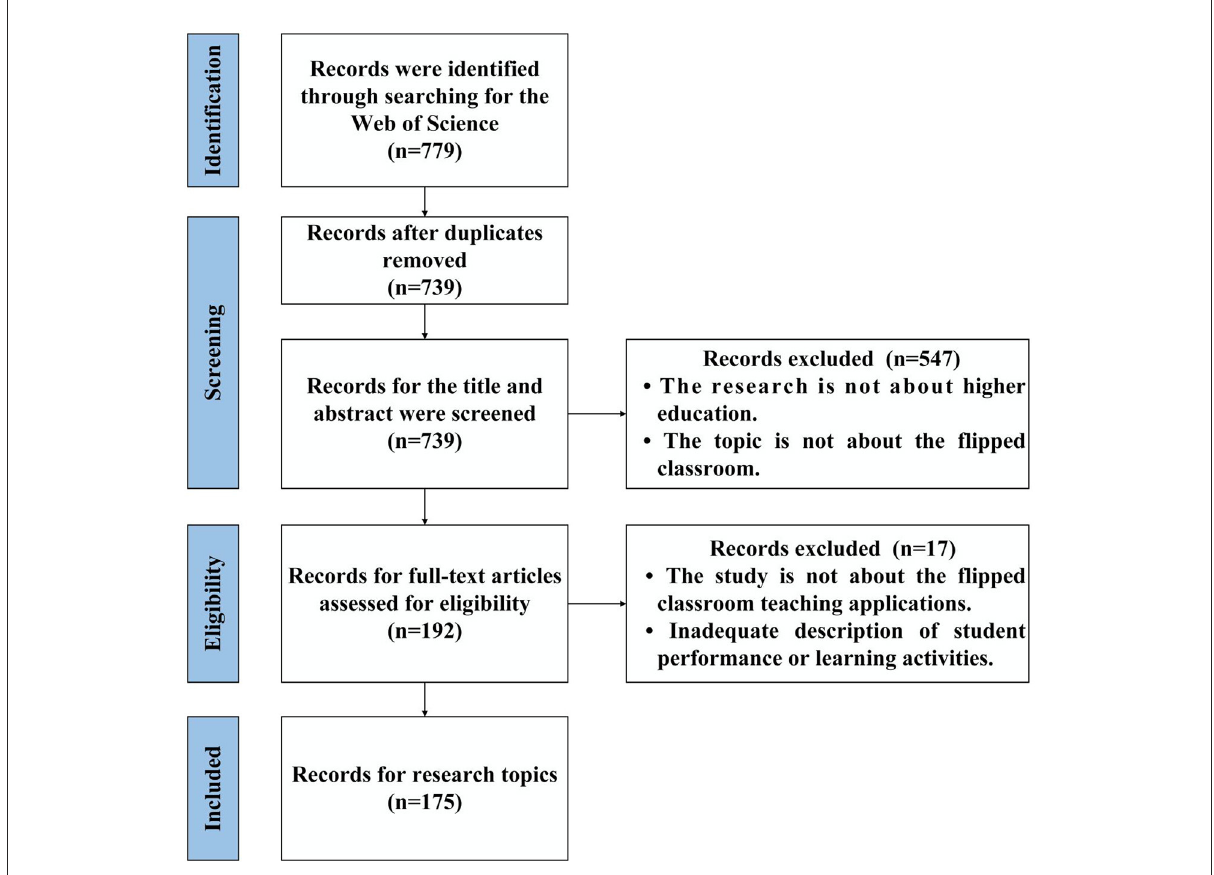
FIGURE1 Review literature screening PRISMA flow chart.